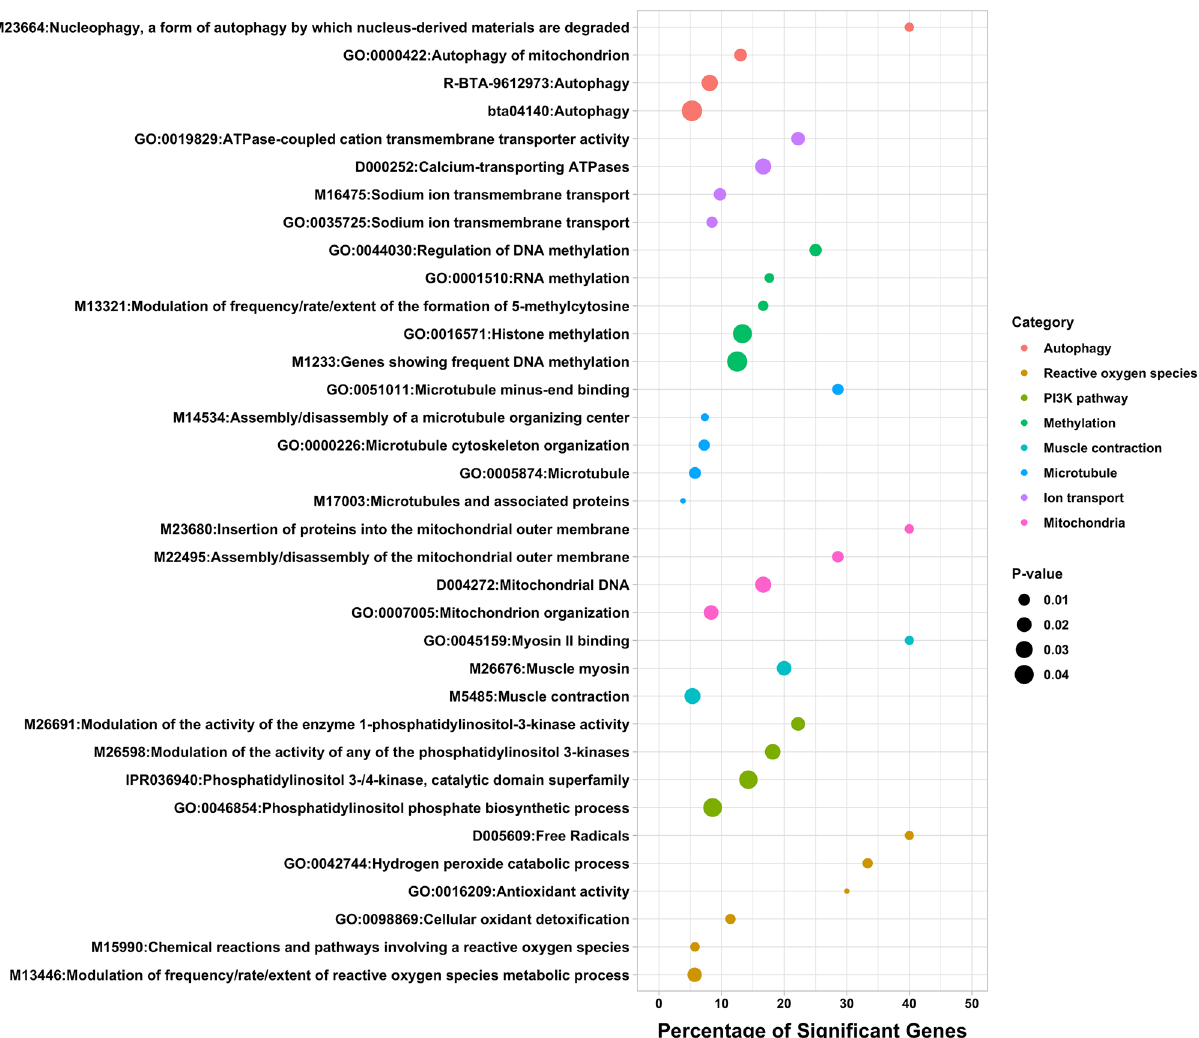
Figure 4. Functional characterization of persistent DNA methylation changes. The y-axis displays the names of the functional terms, the size of the dots represents the significance of the enrichment (-log10 P -Value, Fisher’s exact test) and x-axis represents the percentage of significant genes in each